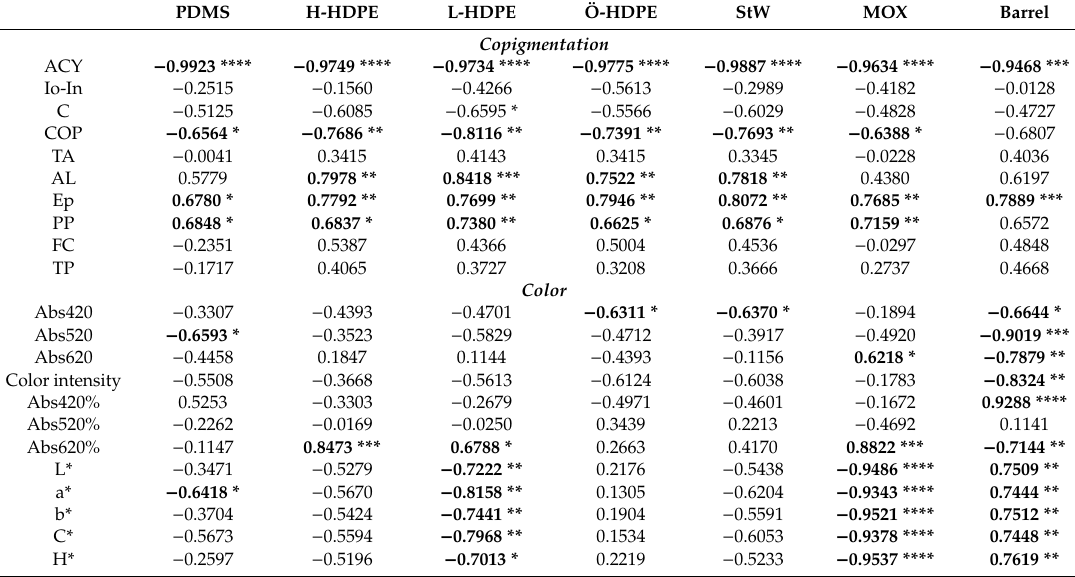
Table 3. Correlation coe ffi cients between oxygen supplied and analyzed parameters of wines from di ff erent aging